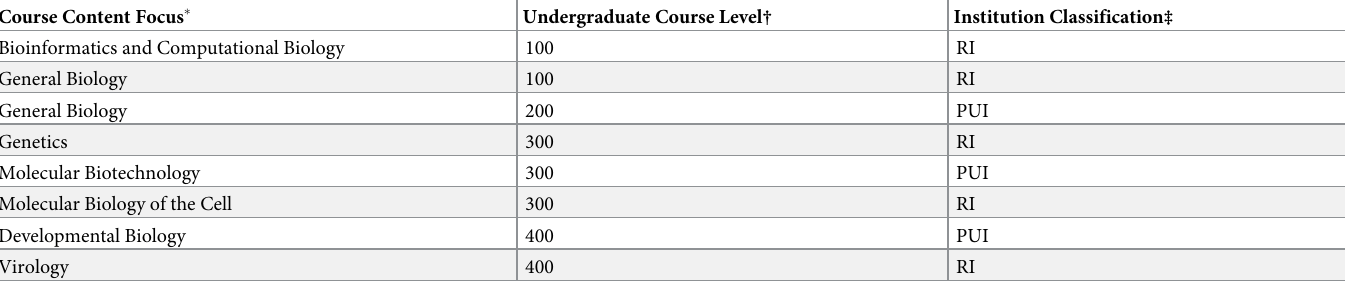
Table 2. The bioinformatics sequence similarity learning resource was implemented in a diverse set of courses across program-level and institution classification. Course Content Focus